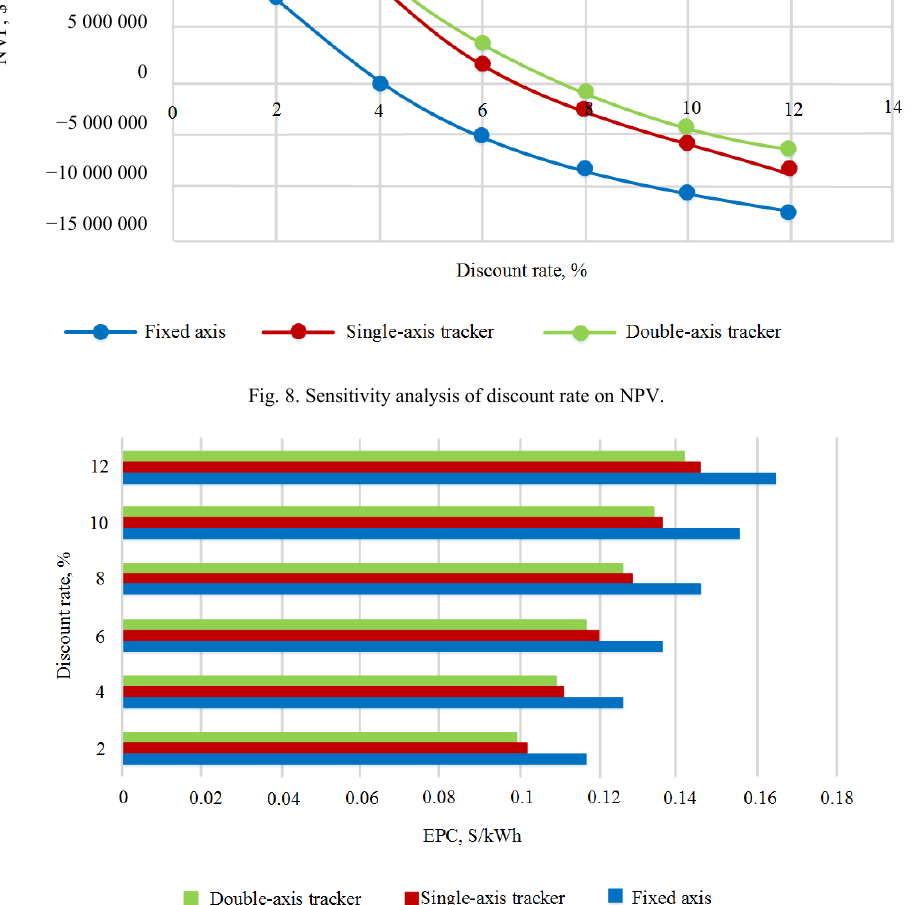
Fig. 9. Sensitivity analysis of discount rate on